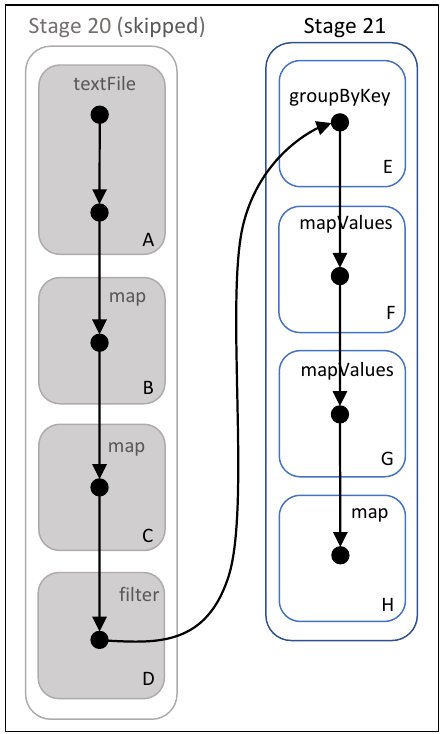
Figure 17. DAG of final stages. Boxes with letters A–H represent transformations on